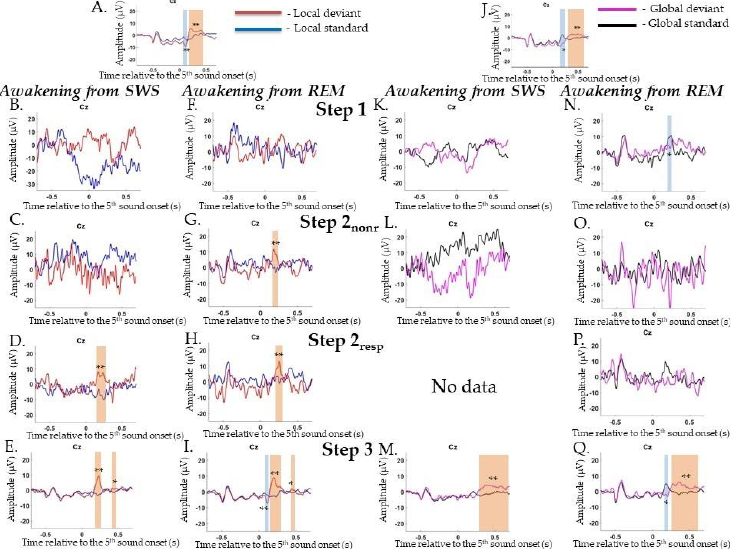
Figure A1. Event-related responses to violation of local regularity and global regularity in the sessions A1 with awakening from slow-wave sleep and rapid eye movement sleep. SWS, slow-wave sleep; REM, rapid eye movement sleep; Step 1, period of awakening when delta or theta prevail in EEG, the motor response is absent; Step 2 nonr , period of awakening when alpha prevails in EEG, the motor response is absent; Step 2 resp , period of awakening when alpha prevails in EEG, the motor response is slow; Step 3, period of awakening when alpha prevails in EEG, the motor response is accurate and timely; s, second; red line, averaged local deviants; blue line, averaged local standards; magenta line, averaged global deviants; black line, averaged global standards; No data, no data went into analysis. ( A ) Local mismatch response in EEG in Wake pre session. ( B – E ) The session with awakening from SWS for local irregularity. ( F – I ) The session with awakening from REM for local irregularity. ( J ) Global mismatch response in EEG in Wake pre session. ( K – M ) The session with awakening from SWS for global irregularity. ( N – Q ) The session with awakening from REM for global irregularity. The blue-shaded region is a pool of negative clusters. The orange-shaded region is a pool of positive clusters. * p < 0.025, ** p <